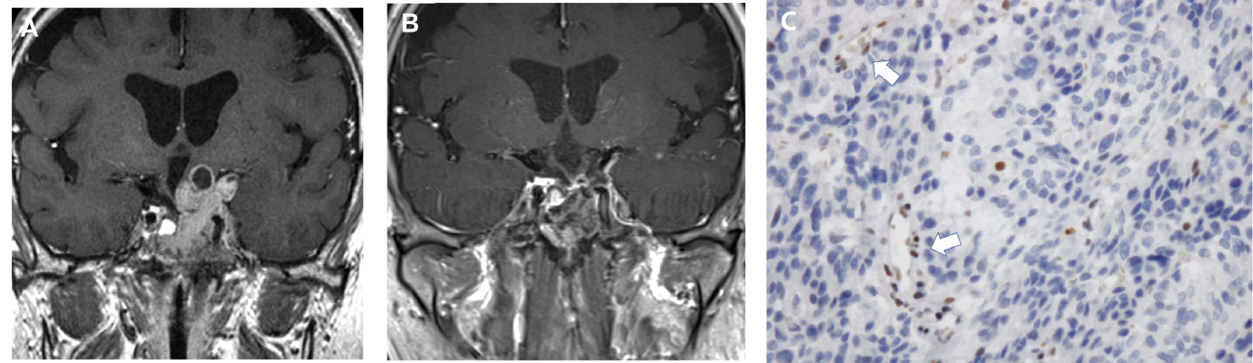
Figure 2. A case of refractory aggressive prolactinoma treated with temozolomide. ( A ): Coronal section of contrast-enhanced T1 weighted image. ( B ): Sagittal section. ( C ): MGMT immunostaining. Vascular endothelial cells show positive staining in the nucleus (arrow), while tumor cells are negative. This patient was a 64-year-old man. Although he underwent transsphenoidal surgery three times and was treated with 7 mg/week cabergoline, the tumor progressed. After commencing temozolomide treatment, the tumor shrank markedly, and serum prolactin decreased to below the reference range. Temozolomide was withdrawn after 34 courses, and no tumor recurred over the next 3 years.